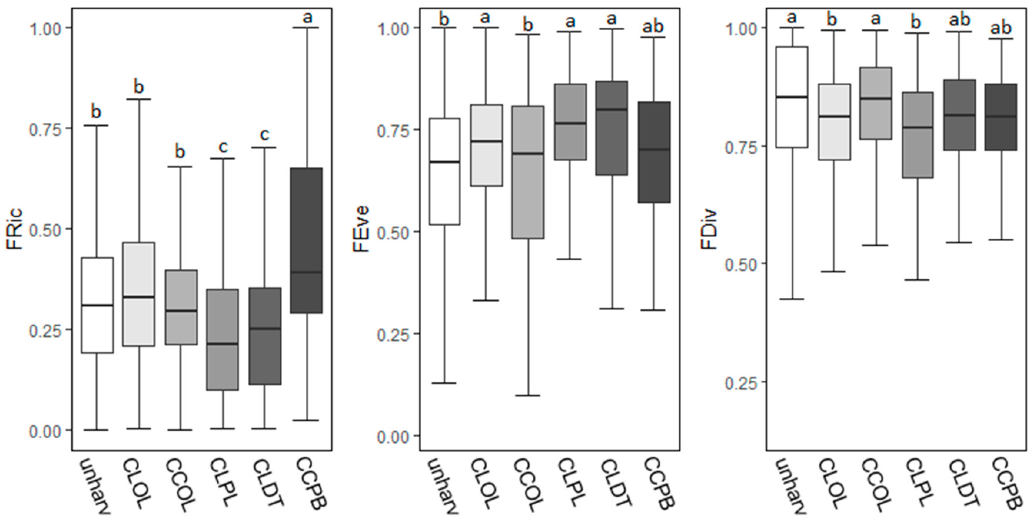
Figure 2. Distribution of functional diversity indices (FRic, FEve, and FDiv) depending on the combined disturbance of retention pattern and site preparation, ordered from lowest to highest soil disturbance degree. unharv: unharvest, CLOL: careful logging only, CLPL: plowing after careful logging, CLDT: disk trenching after careful logging, CCOL: clear cut only, CCPB: prescribed burning after clear cut. Values in each group with different letters denote a significant difference ( p < 0.05).